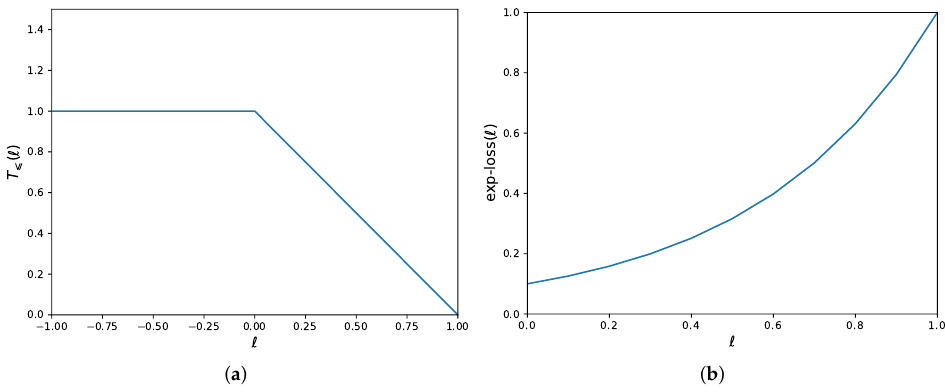
Figure 1. Metric functions: an example: ( a ) truth value function; ( b ) exp-loss